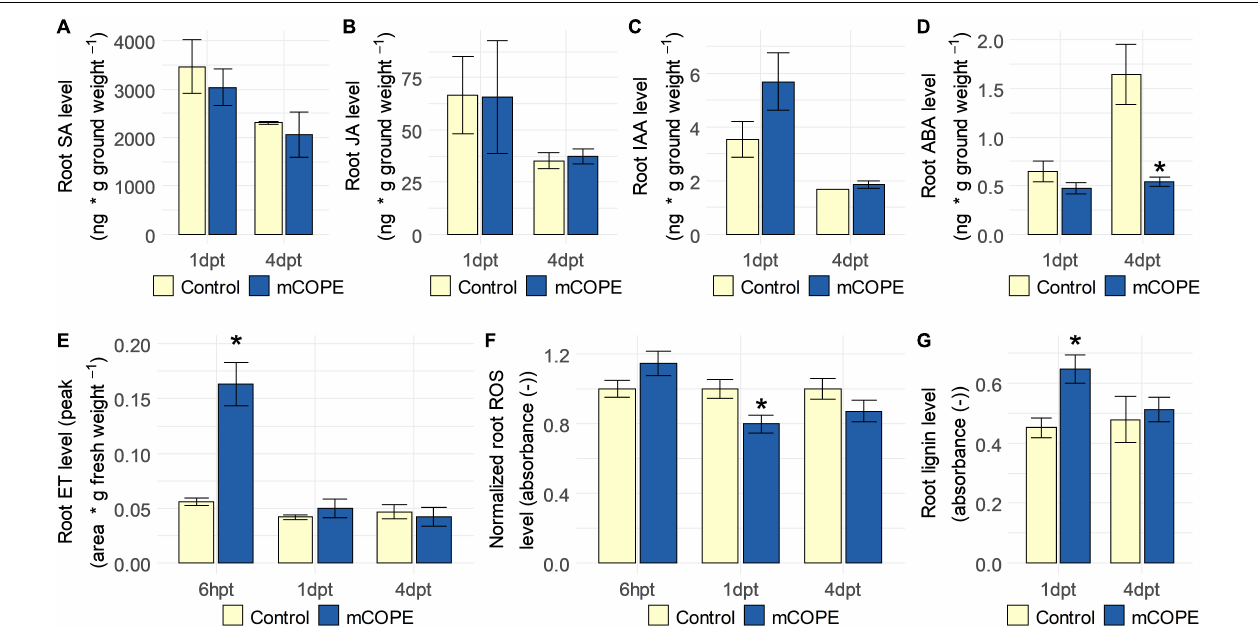
FIGURE 4 | Establishment of induced resistance (IR) via Cucurbitaceae COld Peeling Extract (CCOPE) derived from melon ( Cucumis melo var. cantalupensis ; mCOPE) is associated with ethylene (ET) accumulation, lowered abscisic acid (ABA) concentrations, decreased levels of reactive oxygen species (ROS) and a transient increase in lignin content in roots of rice plants. Shoots of 14-days-old rice plants were treated with the buffer used for CCOPE preparation (Control) or mCOPE. Six hours, 1 day and/or 4 days later (6 hpt, 1 dpt, and 4 dpt, respectively), roots were collected to quantify levels of (A) salicylic acid (SA), (B) jasmonic acid (JA), (C) indole-3-acetic acid (IAA), (D) ABA, (E) ET, (F) ROS, and/or (G) lignin. (A–G) Error bars represent the standard error of the mean. Asterisks indicate significant differences upon comparison of mCOPE-treated plants with same-aged, mock-treated control plants. Statistical differences were determined via a two-sided heteroscedastic t -test ( p < 0.05). Asterisks indicate statistically significant differences upon comparison of CCOPE- and mock-treated cells.